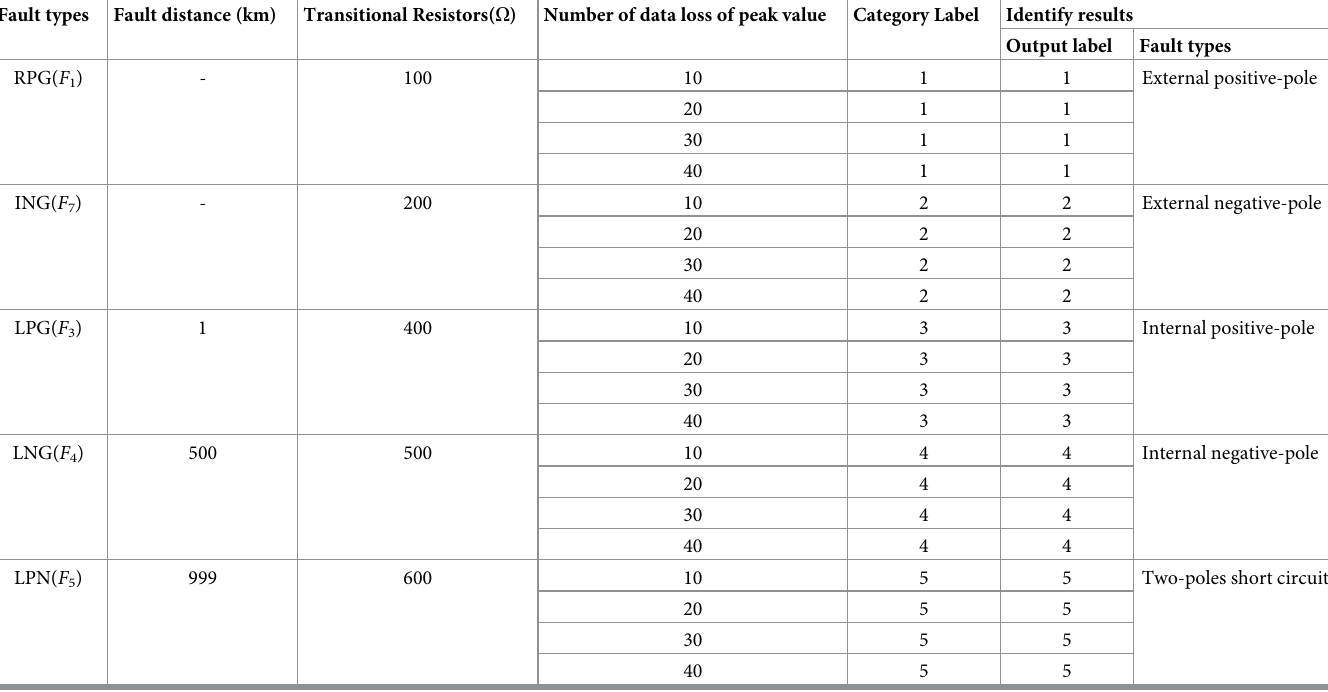
Table 7. Performance test of protection algorithm when data is lost near the fault wave head. Fault types Fault distance (km) Transitional Resistors( O ) Number of data loss of peak value Identify